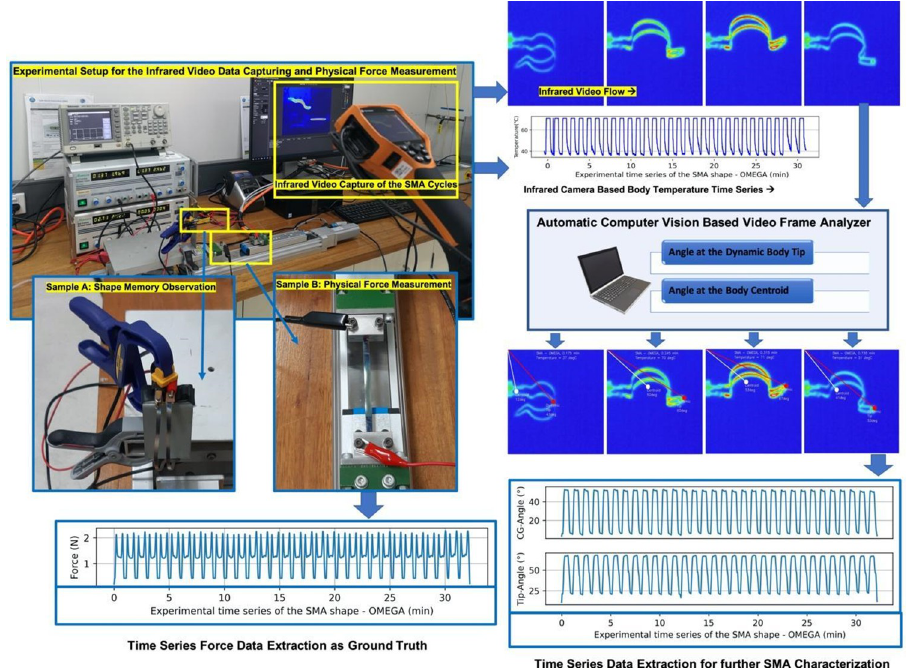
Fig 3. Near-net-shape NiTi SMA overall automated experimental setup consists of two test rigs with automated data logger, an infrared camera with automated data logger, a computer vision system for dynamically analysing video stream, extracting relevant time series data and selecting significant video frames, to be analysed and utilised to train and develop a predictive system. Sample A of the foil was used for infrared video imaging and digitally measuring actuation angles, while the Sample B was used to measure the generated force. This was done simultaneously, to capture a large database for further system implementation.